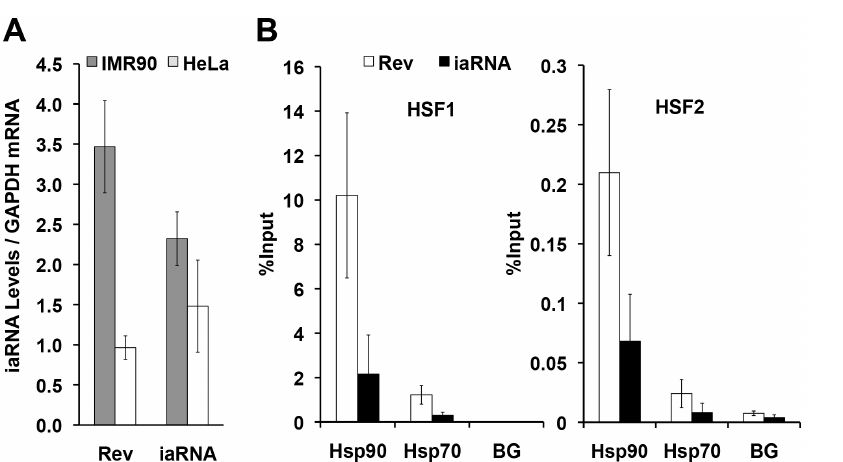
Figure 2. Expression of the RNA construct targeting HSF1 inhibits its occupancy at heat shock loci invivo . (A) Control RNA (RevRA1) and aptamer RNA (iaRNA HSF1 ) constructs are expressed to similar levels in HeLa and IMR90 cells after 24 hrs post transfection (RNA values normalized to GAPDH, n=3). ( B ) Disruption of HSF1’s interaction with its cognate DNA elements by iaRNA HSF1 . ChIP assays in iaRNA HSF1 (or RevRA1) expressing HeLa cells show that iaRNA HSF1 expression can effectively inhibit HSF1 binding to the Hsp90 and Hsp70 promoter loci in vivo (n=3). Antibodies used in ChIP assays are specific for mammalian HSF1 or HSF2 proteins [20]. BG = Background.